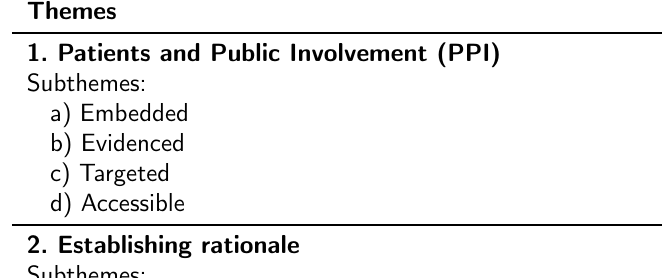
Table 1: Summary table of themes and